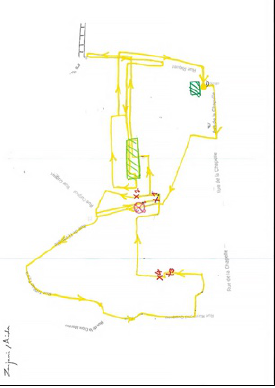
Figure 3. Example of Traces &